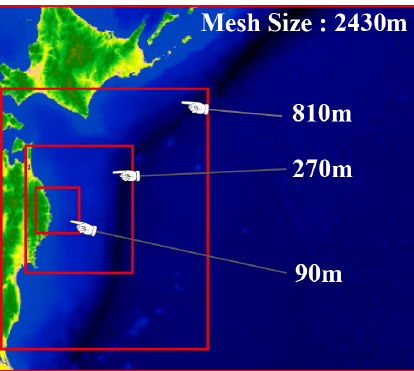
Figure 4. Nested analysis regions (adapted from Kotani et al.,